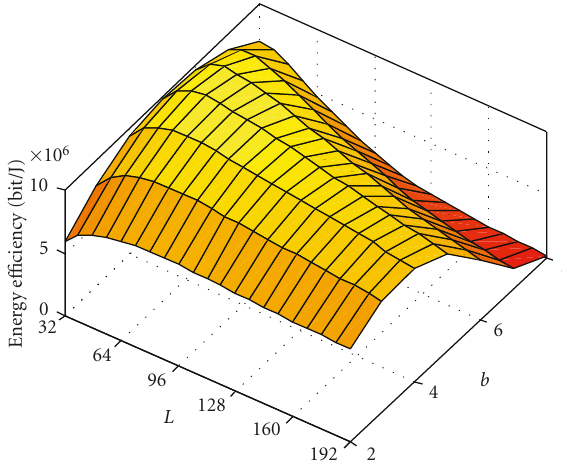
Figure 4: Energy e ffi ciency versus the packet size and modulation level for the cooperation scenario ( r sd =